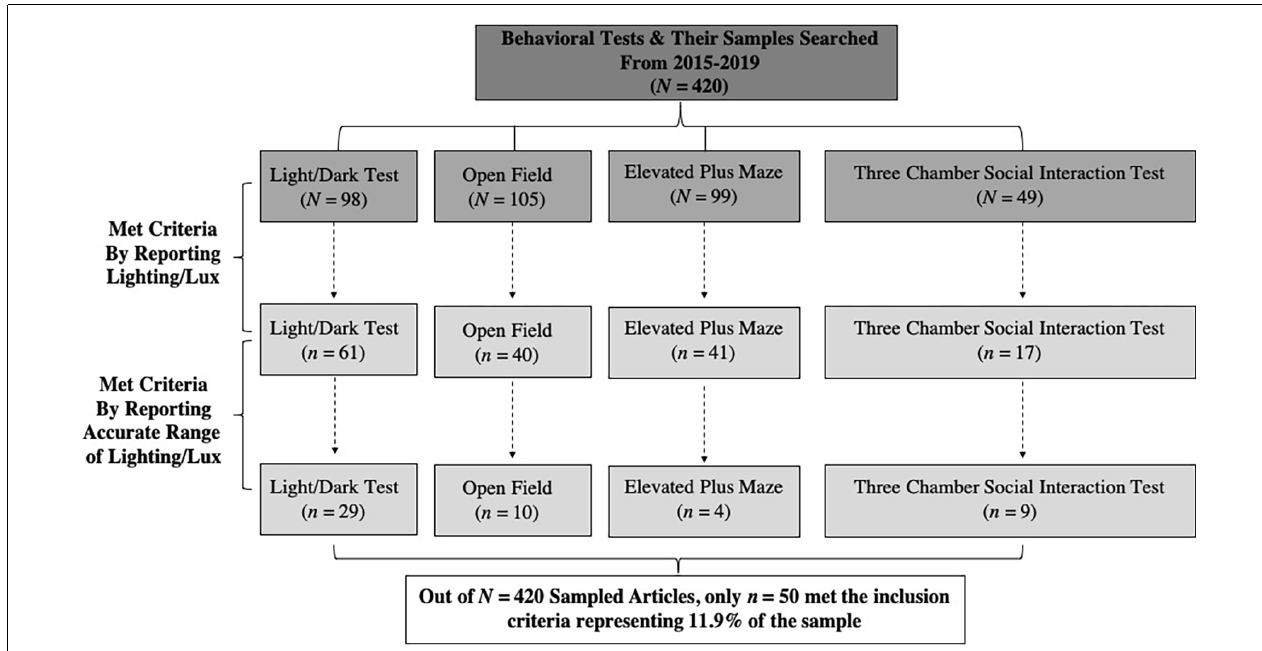
FIGURE 1 | This figure illustrates the flow chart of how the 420 behavioral articles that were searched for to generate an equal representative sample ( n = 105 articles of each behavioral test) comprising the Light/Dark Test, Open Field Test, Elevated Plus Maze Test, and the Three Chamber Social Interaction Test were sampled from 2015 to 2019 ( n = 20–22 per year; upper dark gray rectangles ). Of the N = 420 sampled, only n = 351 met the criteria for animal behavioral test relevance. The publications were then examined for meeting the inclusion criteria for reporting a lighting/Lux value for ethological controls for either anxiogenic or anxiolytic responses ( middle light gray rectangles ). Next, the refined number of articles were then examined for meeting the inclusion criteria for reporting accurate ranges of lighting/Lux for ethologically relevant stimuli motivation purposes that align with the test’s purpose in the field of behavioral neuroscience ( lower light gray rectangles ). Through the criteria used, 11.9% of the sampled articles across the behavioral tests were published using appropriate ethological motivational principles ( white lowest rectangle ) and only n = 50 met the full inclusion criteria, with the Light/Dark Test having better reporting (62.25%), followed by the Open Field (30.09%), then the Elevated Plus Maze (41.41%), and finally the Three Chamber Social Interaction Test with the worst (34.69%) of the respective samples.